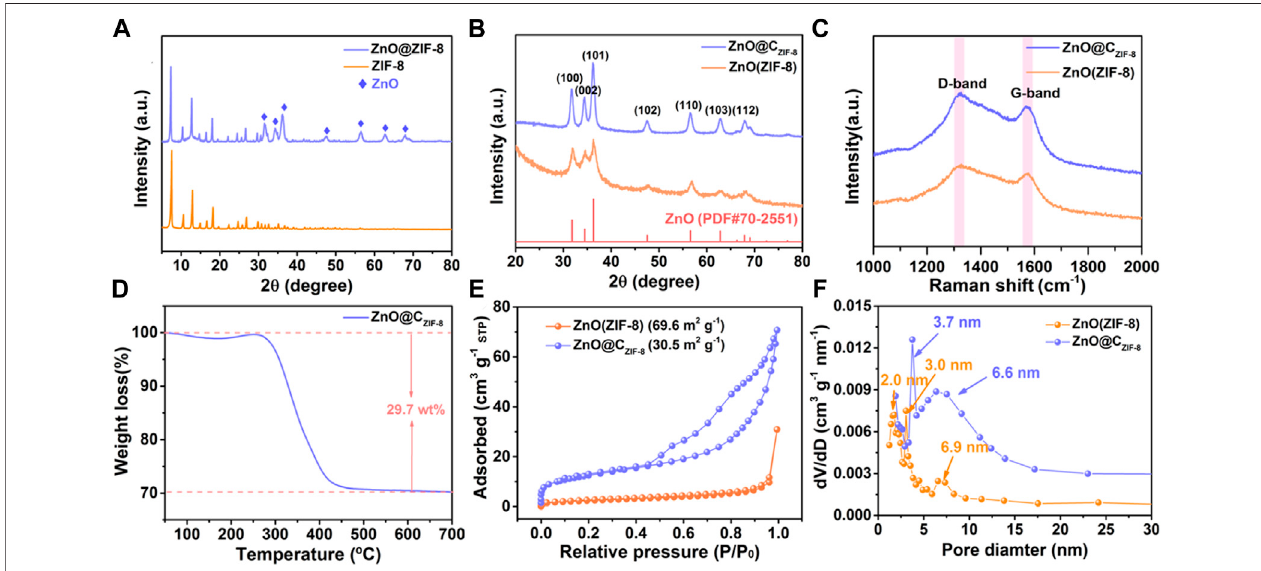
FIGURE 2 | XRD patterns of (A) ZIF-8 and ZnO@ZIF-8, (B) ZnO (ZIF-8), and ZnO@C ZIF-8 . (C) The Raman spectra of ZnO (ZIF-8) and ZnO@C ZIF-8 . (D) The TGA curve of ZnO@C ZIF-8 . (E) N 2 adsorption – desorption isotherms and (F) pore size distribution curves of ZnO (ZIF-8) and ZnO@C ZIF-8